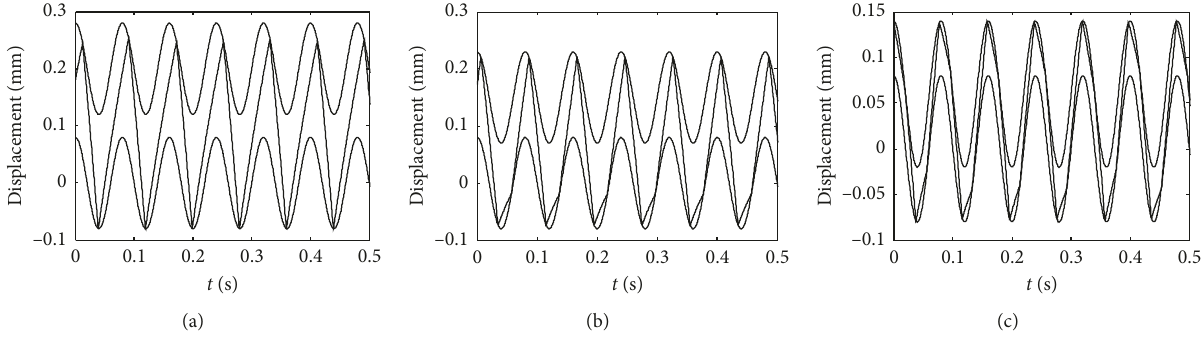
Figure 6: Equivalent displacements. (a) j